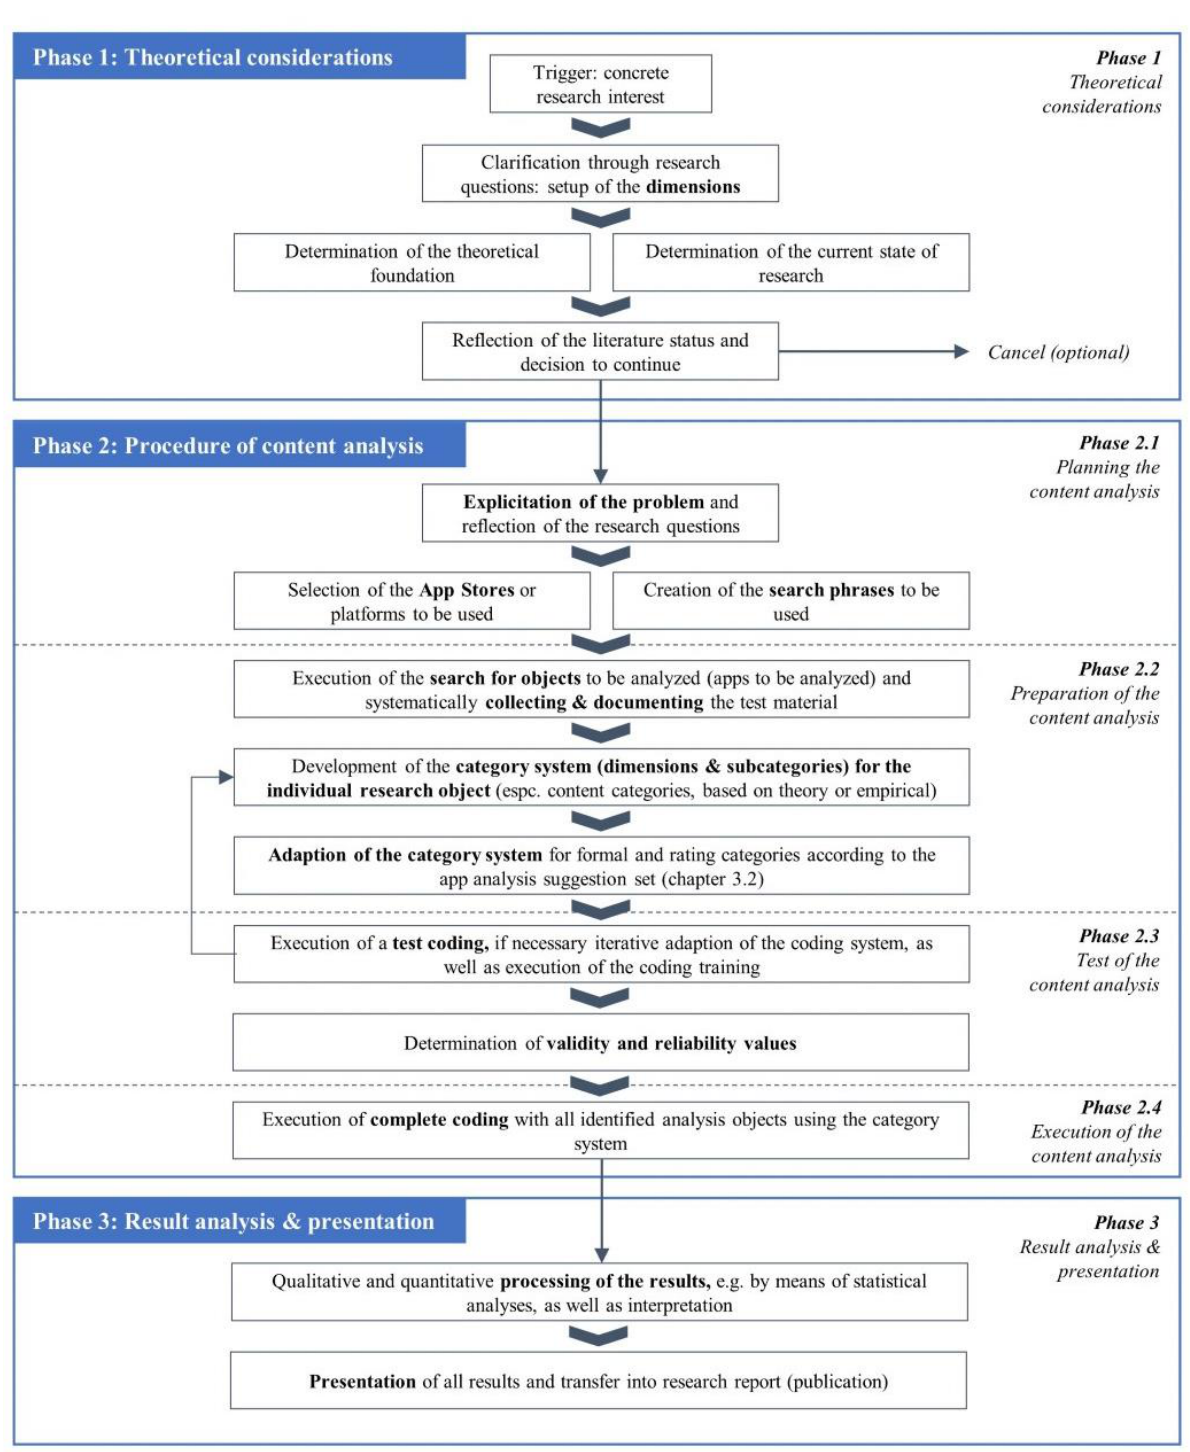
Figure 1. Procedure for content analysis of smartphone apps (oriented on research procedures [8], [9],